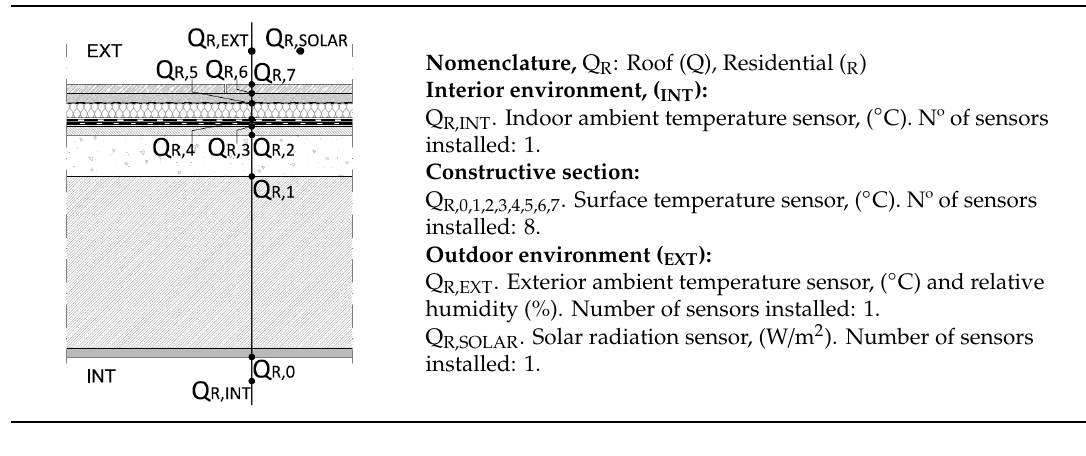
Table 4 . Location and description of sensors located on the water-covered roof of the MUA.